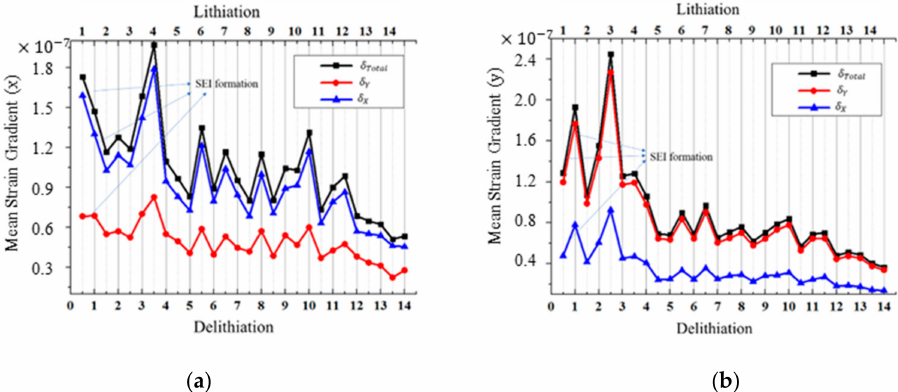
Figure 7. ( a ) Evolution of mean strain gradient (MSG) along x direction in electrochemical cycles, and ( b ) evolution of MSG along y direction in electrochemical